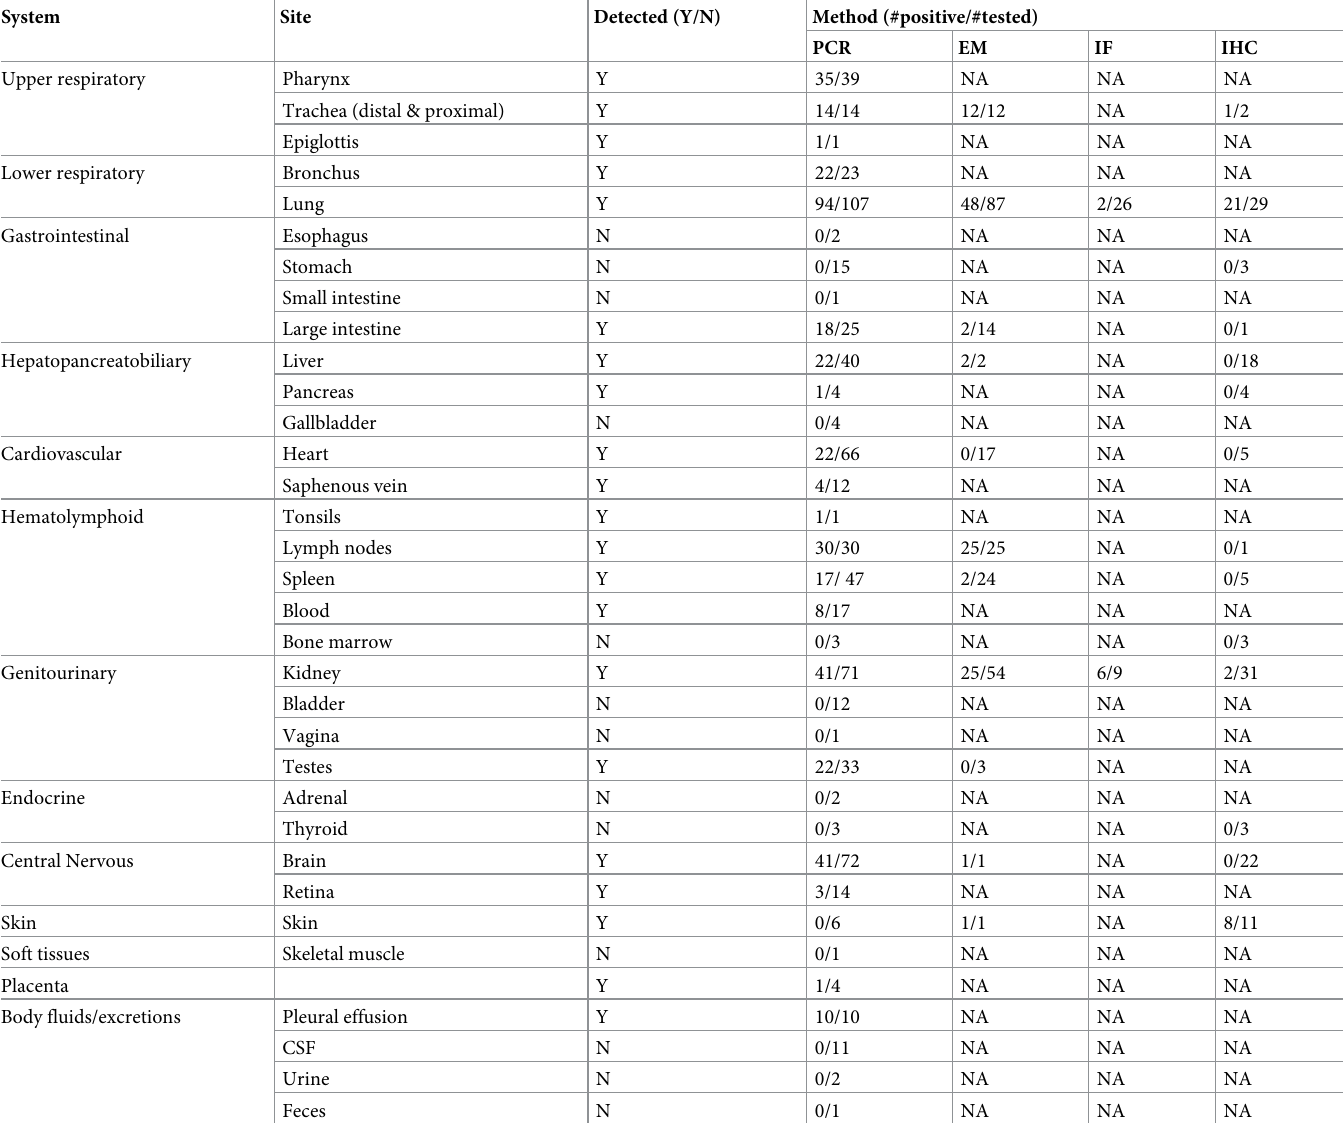
Table 5. Detection of SARS-CoV-2 in different organs in COVID-19 patients. System